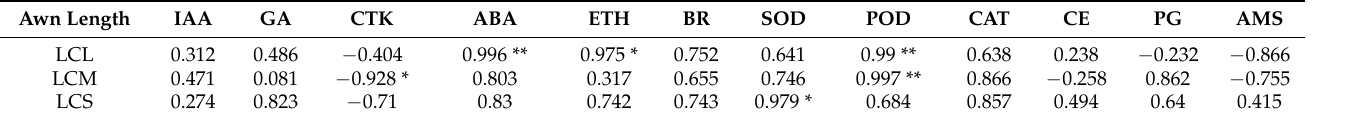
Table 3. Correlation analysis of the length change of awns with hormones and enzymes in three accessions at four